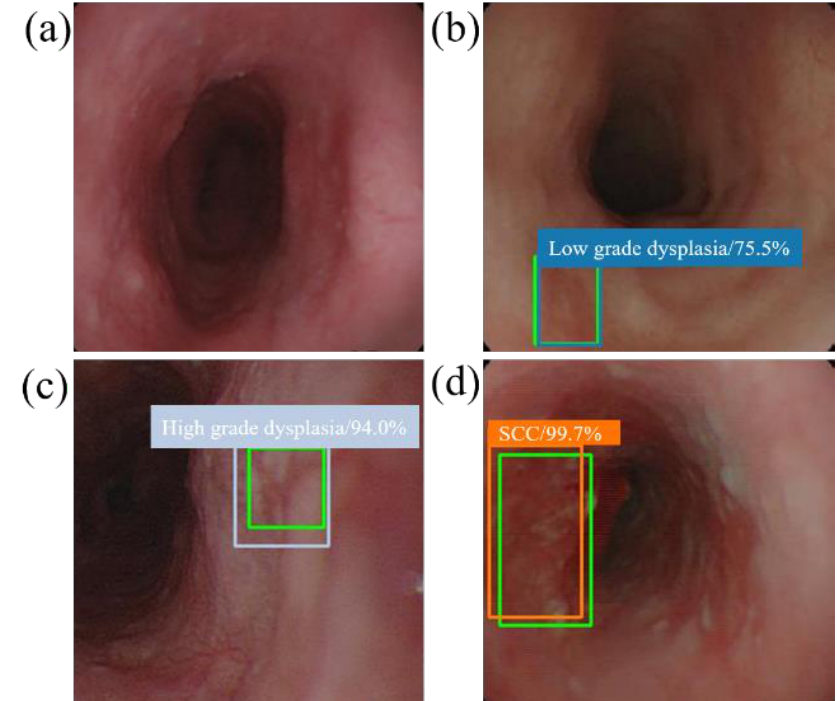
Figure 4. SSD diagnostic results of WLI esophageal neoplasm image. All green boxes in the figure are ground truth. The numbers in the label indicate the probability of being judged as the number of esophageal cancer stages in the box. ( a ) Image of a normal esophagus. No frame is displayed under the SSD diagnosis; thus, the SSD diagnosis was normal esophagus. ( b ) A blue border box is displayed around the lesion area, determined as low-grade dysplasia. ( c ) A gray border box is displayed around the lesion area, determined as high-grade dysplasia. ( d ) Esophageal endoscopy image with an esophageal cancer area. Under SSD diagnosis, an orange bounding box surrounds the lesion area and determines that the lesion area is cancer.